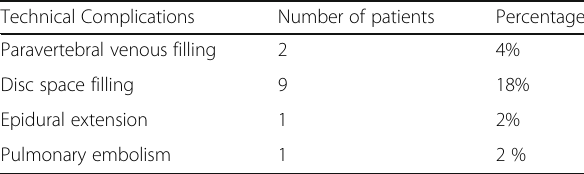
Table 3 Technical complications